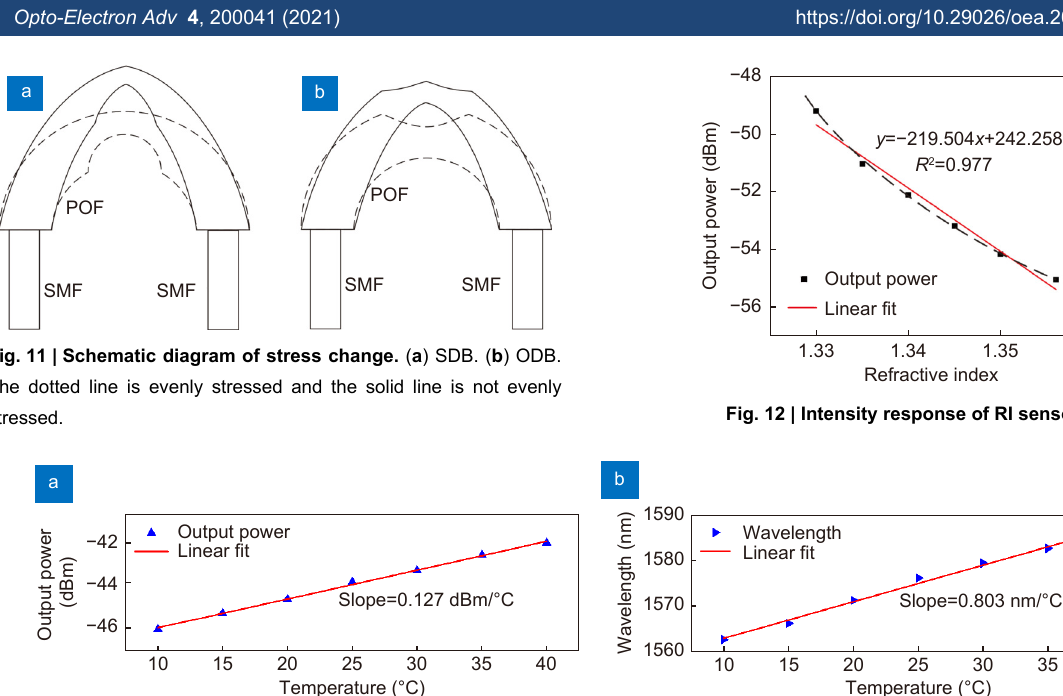
Fig. 13 | Transmission response of the perfluorinated POF-based RI sensor at different temperature. ( a ) Output power response. ( b ) Wavelength